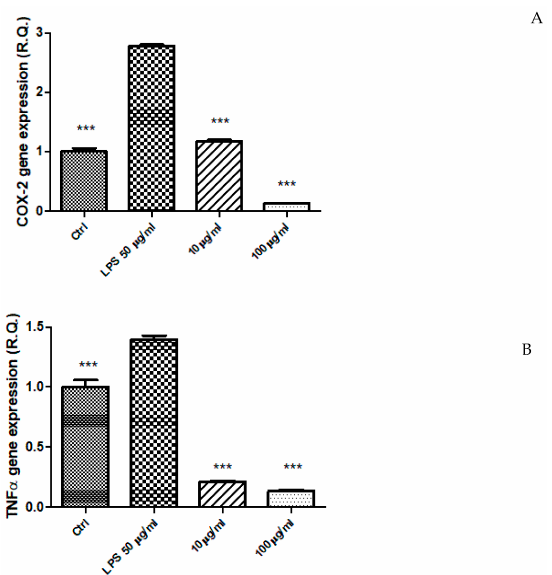
Figure 6. ( A ) Inhibitory effect of the ethyl acetate extract 10–100 µg/mL from the aerial parts of Pelargonium quercetorum on COX-2 gene expression in isolated mouse colon specimens exposed to LPS (50 µ g/mL). *** p < 0.001 vs. LPS group. ( B ) Inhibitory effect of the ethyl acetate extract 10–100 µ g/mL from the aerial parts of Pelargonium quercetorum on TNF α gene expression in isolated mouse colon specimens exposed to LPS (50 µ g/mL). *** p < 0.001 vs. LPS